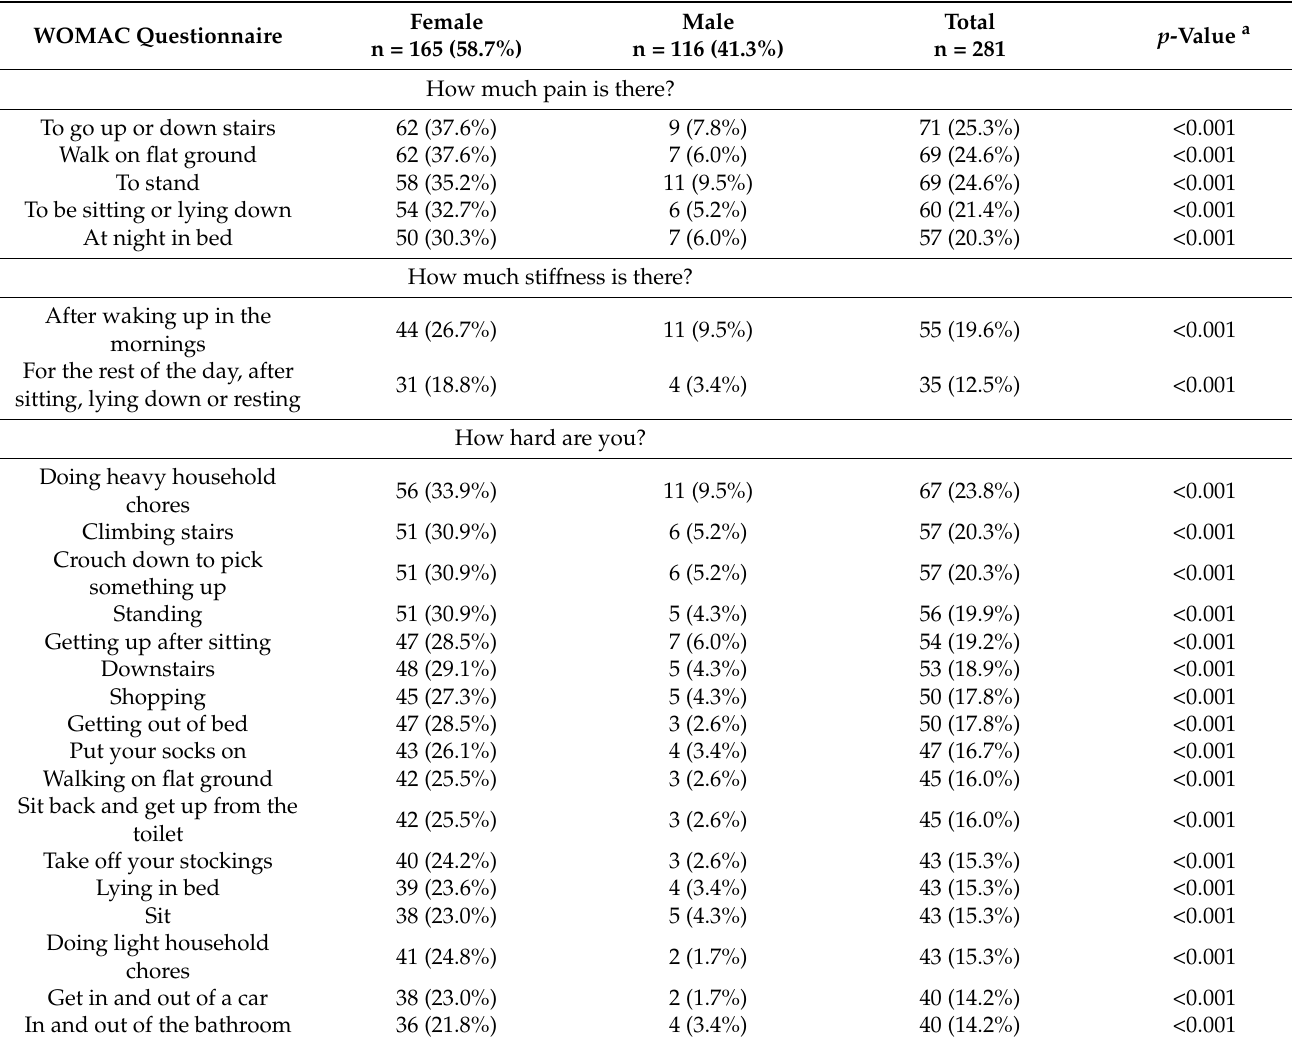
Table 2. Symptoms and physical activity participation with the WOMAC questionnaire by sex at the follow-up (four